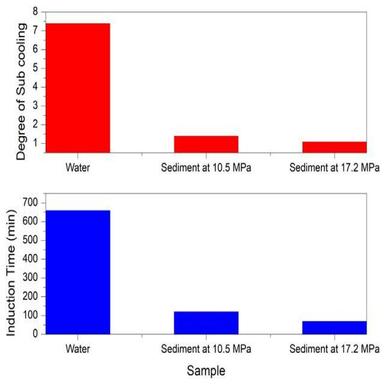
Induction time and Degree of sub-cooling observed in water and sediment sample. Fig. 14. Gas consumption in sediment samples at different conditions.